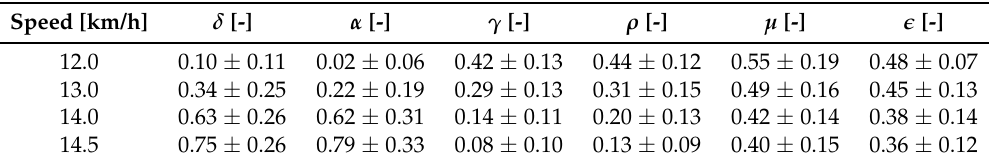
Table 10. Infringements ( δ and α ) and performance ( γ , ρ , and µ ) normalized biomechanical indices evaluated for 864 step sequences, corresponding to 25,920 steps (mean values of the synthetic index (cid:101)